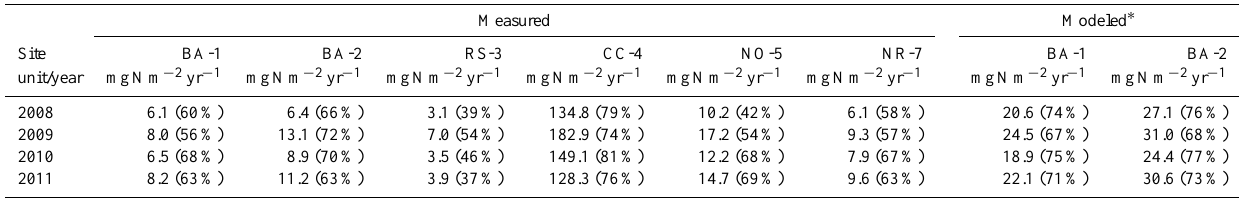
Table 2. Measured and modeled annual DIN loads per unit catchment area from all six Balsjö catchments during 2008–2011. The percentage of NO − of the total load is given in brackets. 3